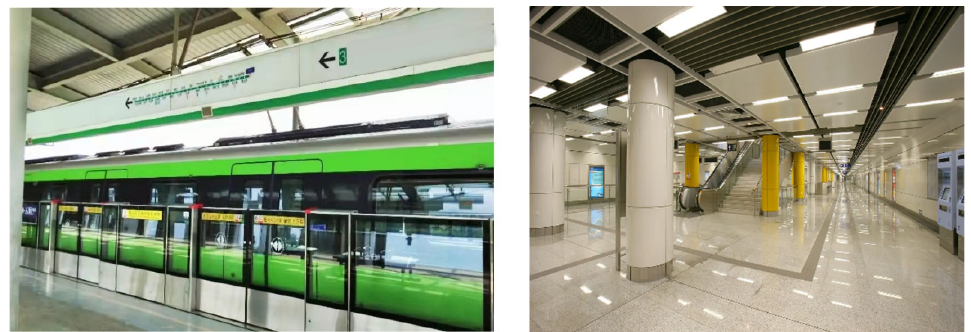
Figure 3. A sample photograph of Nanjing Metro station and the platform.